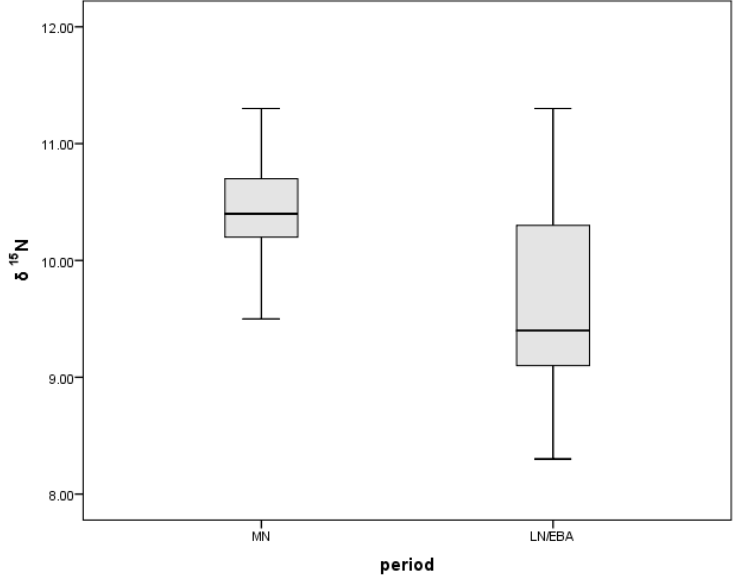
Figure 14. δ 15 N from megalithic individuals in Falbygden (teeth). Boxplot with line: median, box: 25 th - 75 th percentile, whisker: ca 95% of the data. MN: Middle Neolithic, LN/EBA: Late Neolithic/ Early Bronze